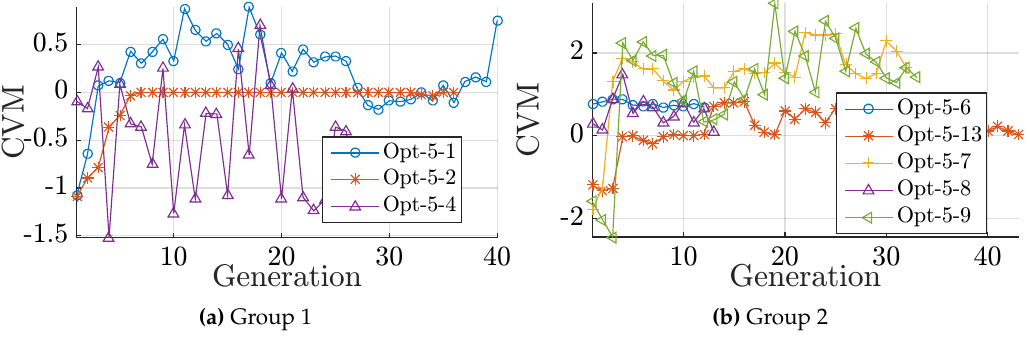
Figure 19. Development of the feasibility, given as the generation wise validity ratio and the generation median of CVM. ( a ) Group 1; ( b ) Group